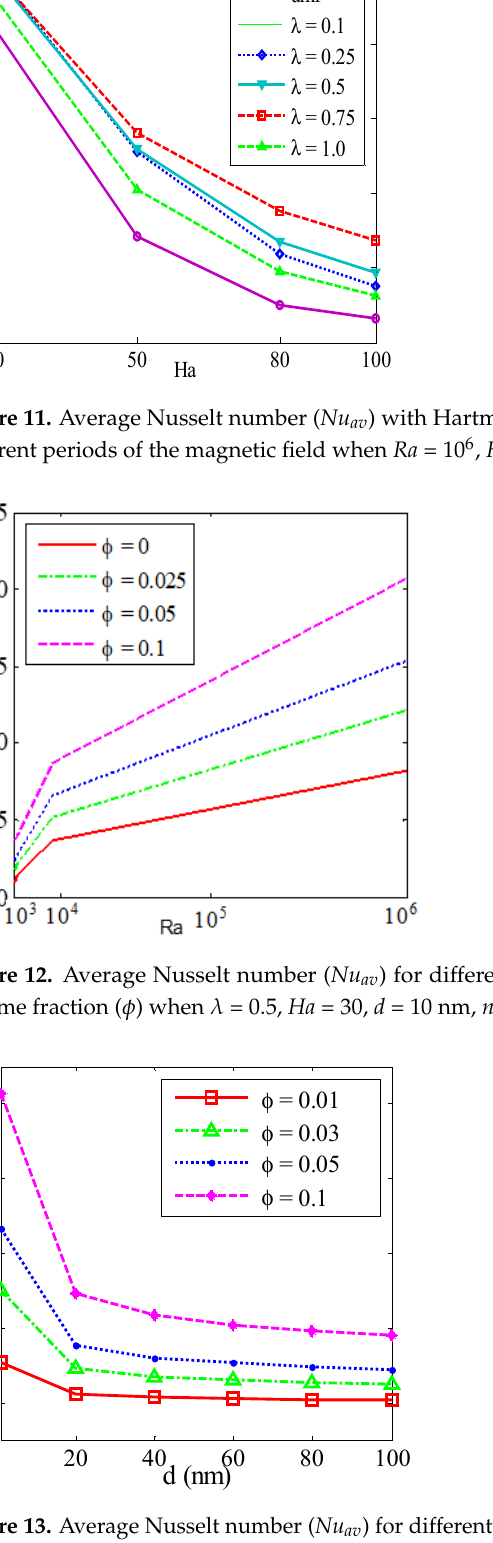
Figure 14. Average Nusselt number ( Nu av ) for the nanoparticles shape ( n ) and nanoparticles volume fraction ( ϕ ) when Ra = 10 6 , Ha = 30, d = 10 nm, n = 3, λ = 0.5, and τ = 1. Figure 15. Variation of mean Nusselt number ( Nu av ) for various Rayleigh numbers ( Ra ) and Hart- mann number ( Ha ) when ϕ = 0.04, n = 3, d = 10 nm, n = 3, λ = 0.5, and τ = 1.